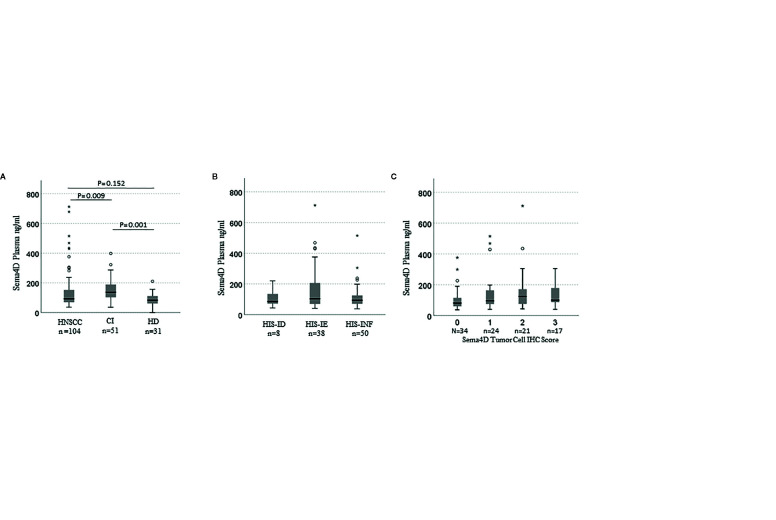
sSema4D in plasma correlates with HIS-IE and Sema4D +ve TC in real time. Box and whisker plots illustrating independent samples Kruskal–Wallis test of (A) sSema4D level in plasma in HNSCC, CI (AI/A/OA) and HD. (B) The sSema4D in relation to the HIS subtypes (INF, IE, ID). (C) sSema4D levels correlate with Sema4D in TC. TC, tumor cell; HIS, histological inflammatory subtype; INF, inflamed; IE, immune excluded; ID, immune deserted. HD, healthy donors; CI, chronic inflammation; AI/A/OA, autoimmune; allergy and osteoarthritis. The circles and asteriks represent samples with higher level brackets.